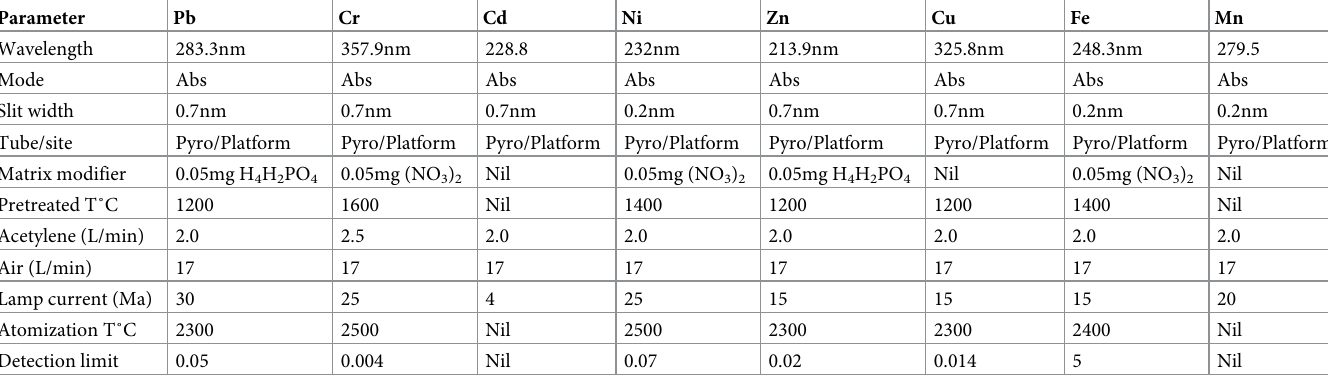
Table 1. Analytical conditions for the determination of heavy metals in water using graphite furnace. Parameter